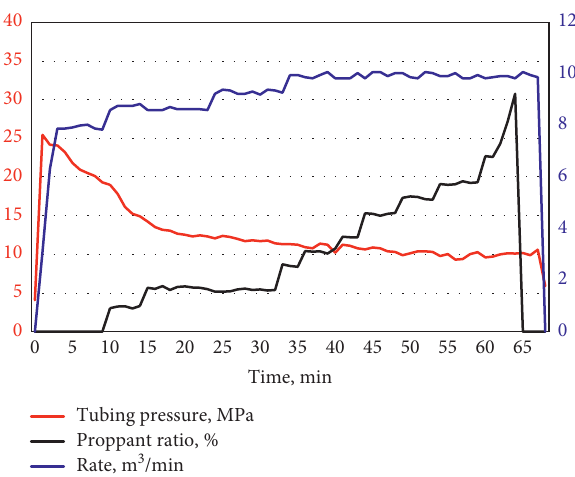
Figure 2: The hydraulic sand fracturing operation curves for some CBM reservoirs.